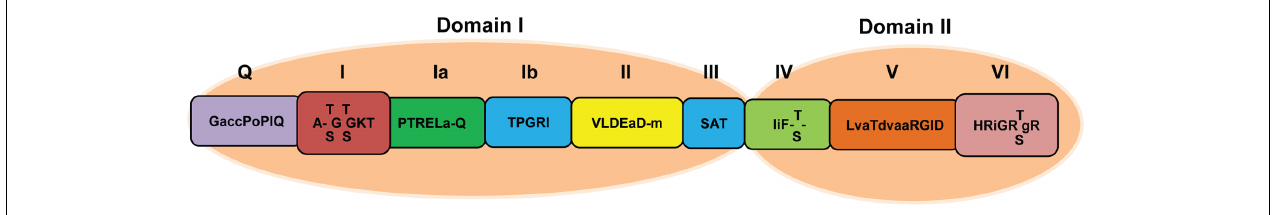
FIGURE 1 | Schematic representation of the domain structure of SF2 family DEAD-box RH. The Q, I, Ia, Ib, II, and III motifs are included in domain I, and motifs IV, V, and VI are in domain II. Capital letters represent highly conserved amino acid sequences with > 80% homology while small letters indicate less conserved amino acid sequences with 50–80%